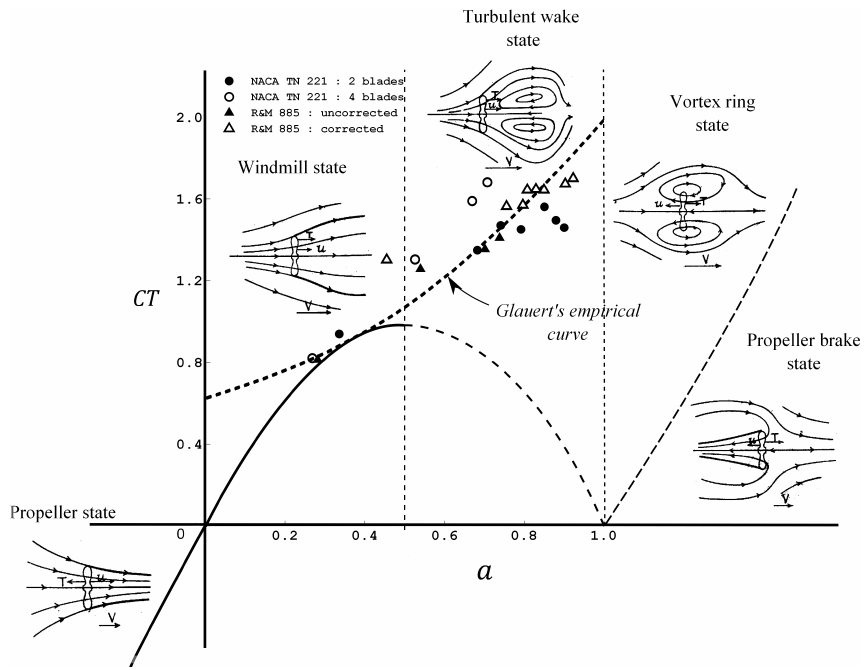
Figure 5. The coefficient of thrust CT as a function of axial interference factor a at different operating flow states of a wind turbine rotor. This figure is based on a compilation of data from Eggleston and Stoddard [46] and Walker [47]. The flow states shown are from Lock et al. [16], representing the velocity patterns induced at the rotor u , the free stream velocity V , and the rotor thrust T